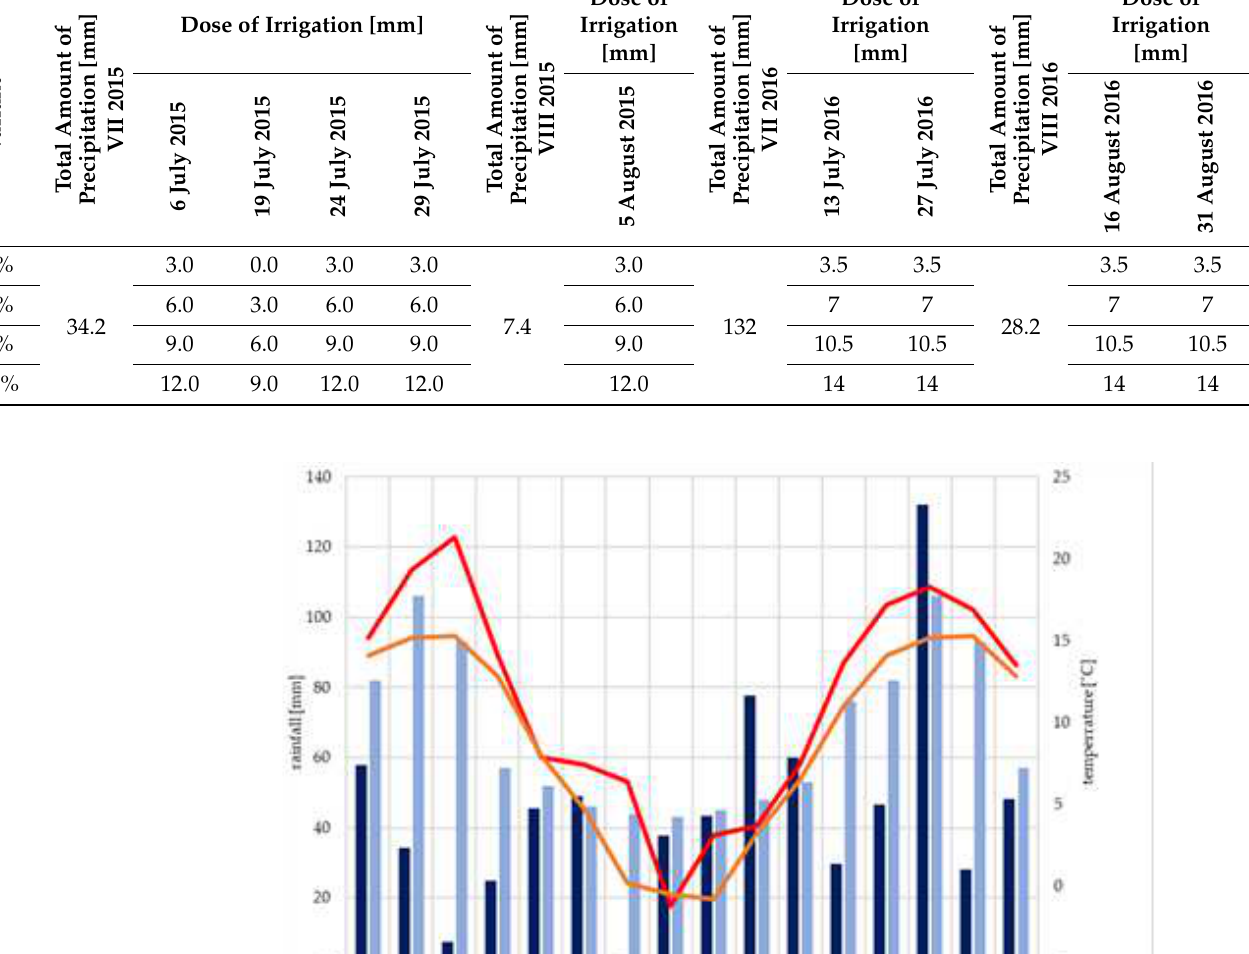
Table 2. Total quantity of precipitation and irrigation rate for each variant and irrigation dates in years’ 2015 and 2016, VII—July, VIII—August—summer in Poland.